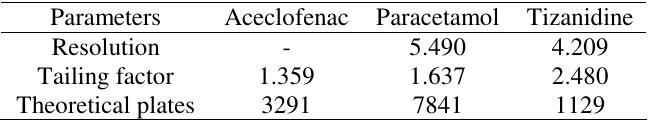
Table 1. Result of system suitability